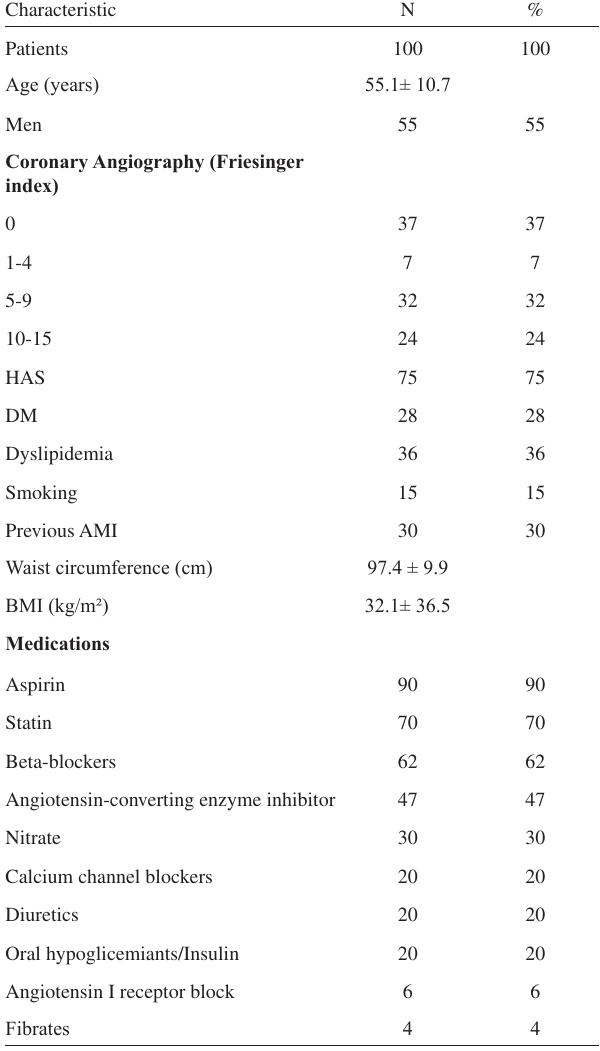
Table 3- Non-invasive test results (mean ±